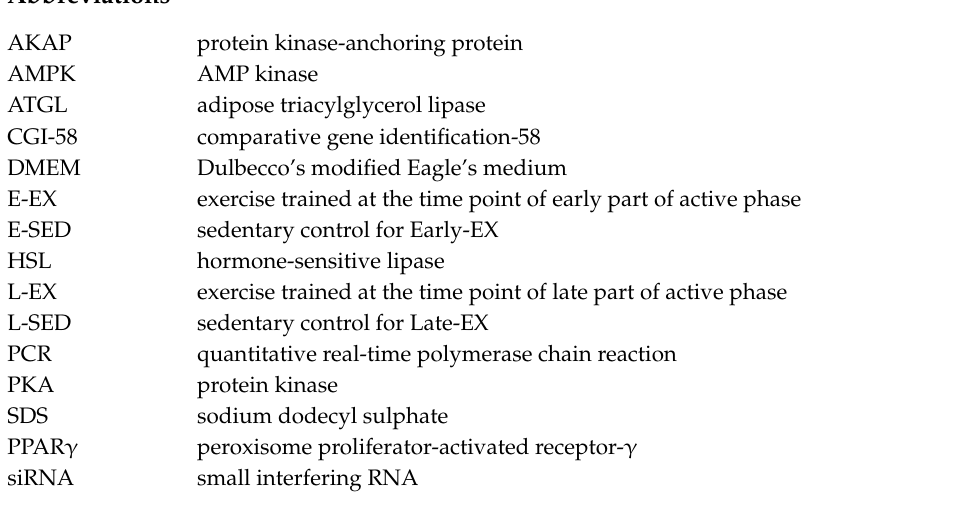
Table S1: Exercise training program, Table S2. Primers sequences for quantitative real-time